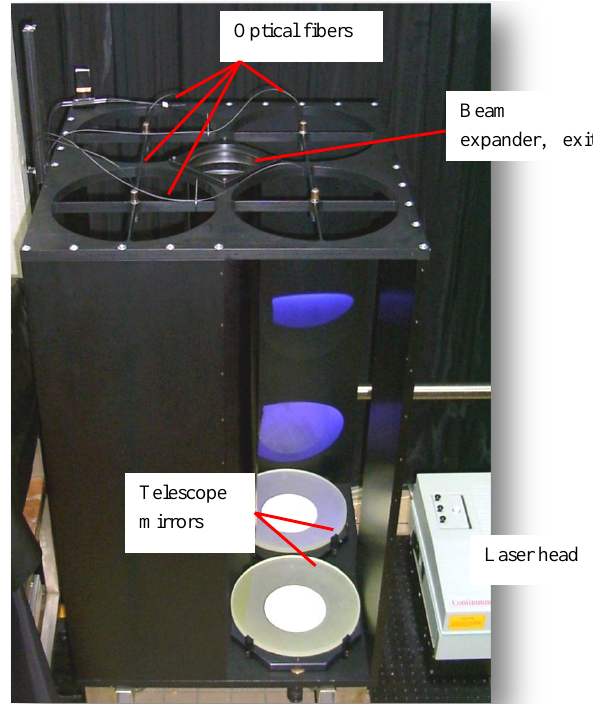
Fig. 3. Photograph of the telescope assembly taken before installa- tion of the windows assembly support. Two of the four telescope mirrors are